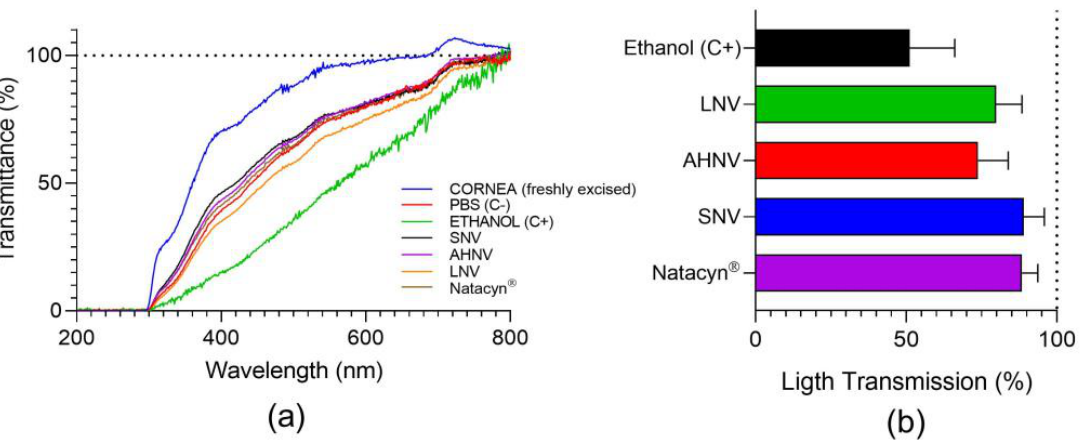
Figure 10. ( a ) Transmittance values in the ultra-visible light spectrum (200–800 nm) of bovine corneas treated 10 min with SNV, AHNV, and LNV. Values are compared with ethanol (C+: positive control), PBS (C − : negative control), and untreated corneas. ( b ) Transmitted light (%) (opacity) values of bovine corneas treated with SNV, AHNV, and LNV. Data were compared with ethanol (C+: positive control).